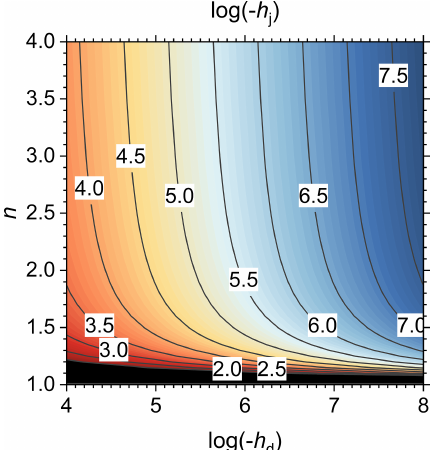
Figure 4. The logarithm of the absolute value of the matric poten- tial at the junction point ( h j , cm H 2 O) as a function of the matric potential at oven dryness ( h d , cm H 2 O) and shape factor n , accord- ing to Eq. (8). The labels of the contour lines denote log( − h j ) . In the black region, h j > −